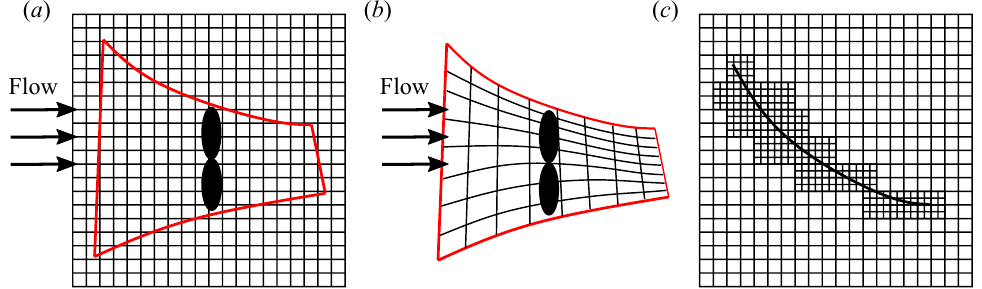
Figure 1. Grid strategies to a turbomachinery problem: ( a ) Cartesian grid, ( b ) channel-conformal structured grid, ( c ) multi-level mesh with AMR. The red solid lines represent the channel, and both the black solid circles in ( a , b ) and the black solid line in ( c ) represent the blades inside the